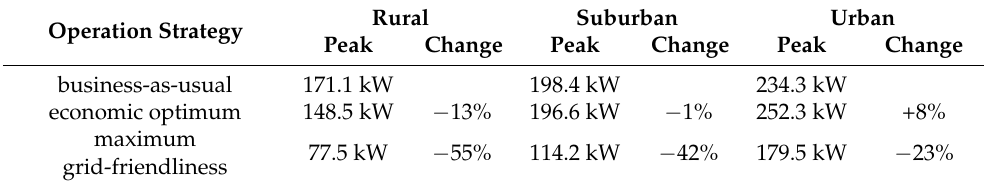
Table 3. Annual peak power at the low-voltage transformer for operation strategies and scenarios.